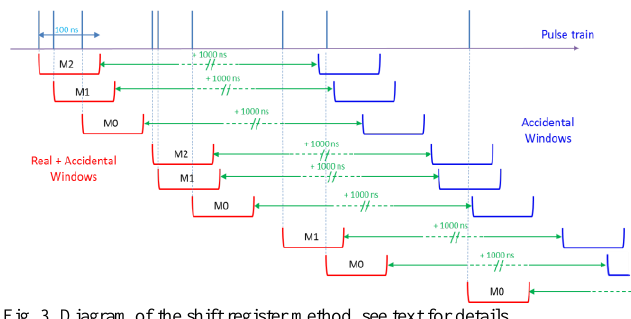
Fig. 3. Diagram of the shift register method, see text for